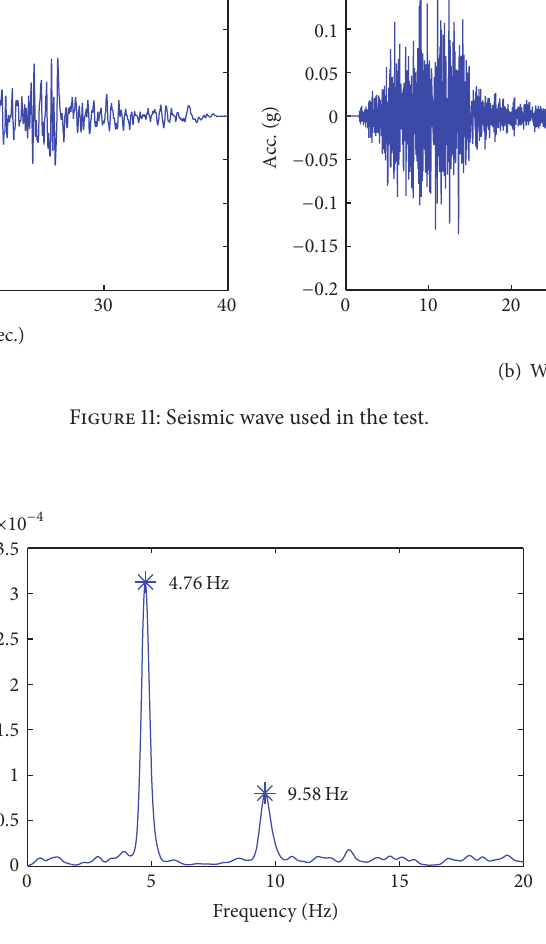
Figure 12: Flourier spectrum of the acceleration at the top of pier2.